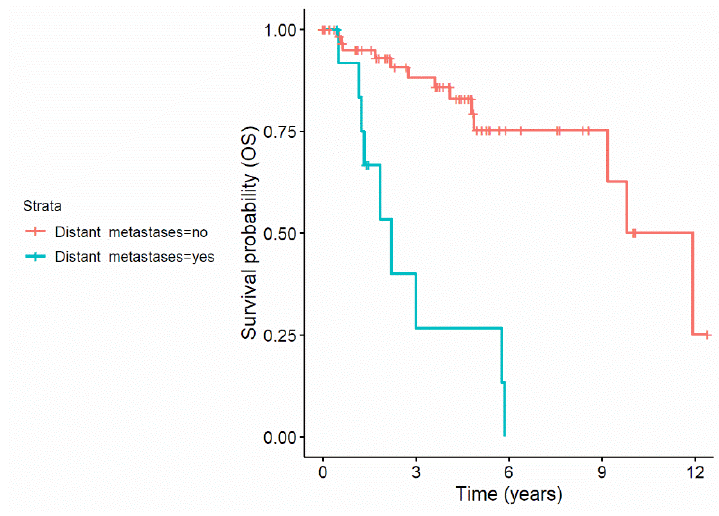
Figure 1. Survival curves of patients with and without distant metastases. Table 4. Univariate and multiple Cox regression for OS.